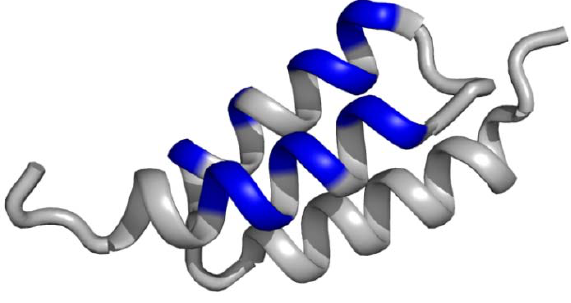
Figure 4. Schematic representation of the Z domain scaffold, termed Affibody, derived from the B-domain of the Staphylococcal aureus immunoglobulin-binding protein A.